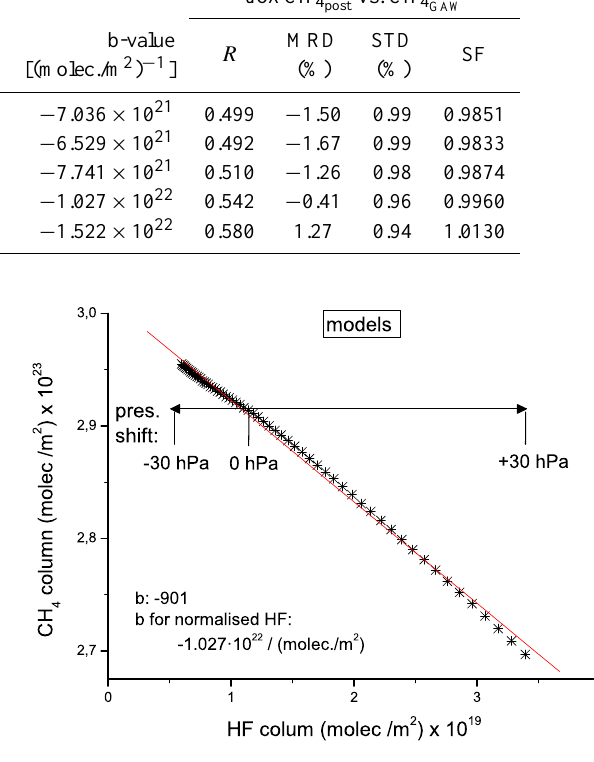
Fig. A3. Correlation plot between the CH 4 and HF total column amounts obtained for different vertical shifts of the CH 4 and HF ACE-FTS profiles.